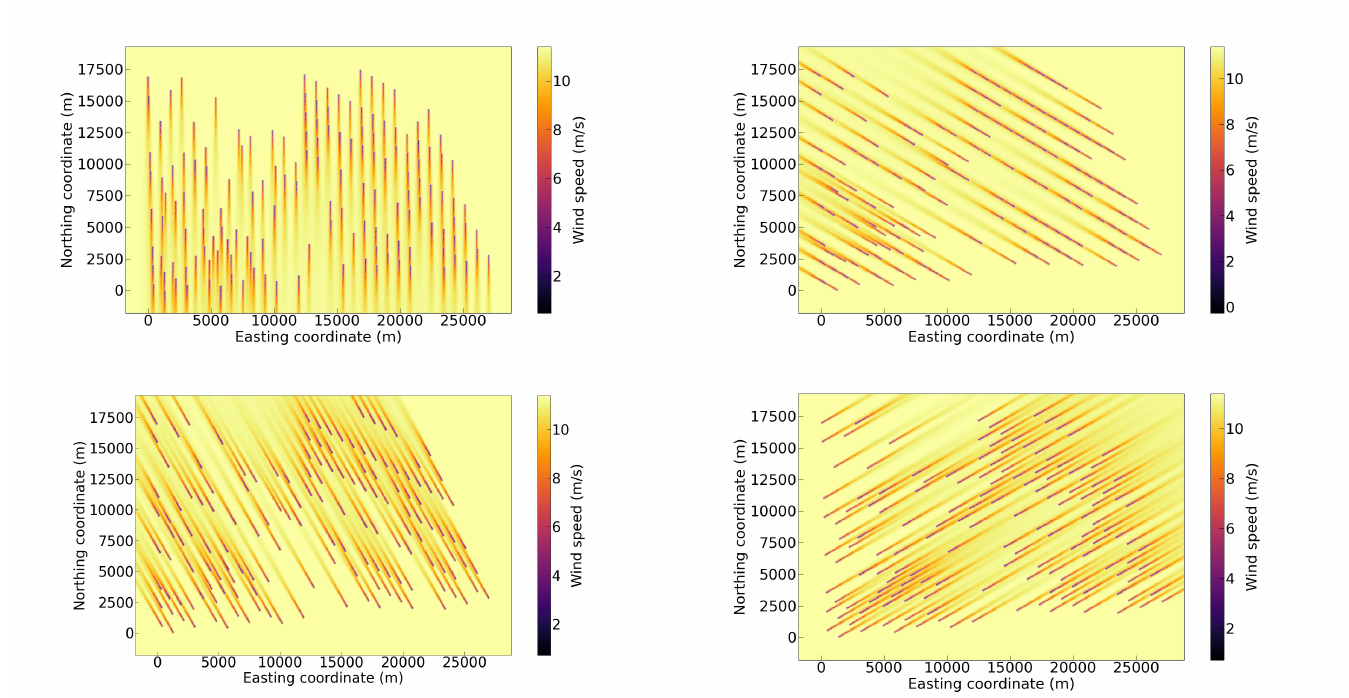
Figure 5. Snapshots of hub-height flow fields for a fixed inflow speed of U F 0 = U (cid:48) different wind directions: 0° ( upper left ), 120° ( upper right ), 150° ( lower left ), and 240° ( lower right ).